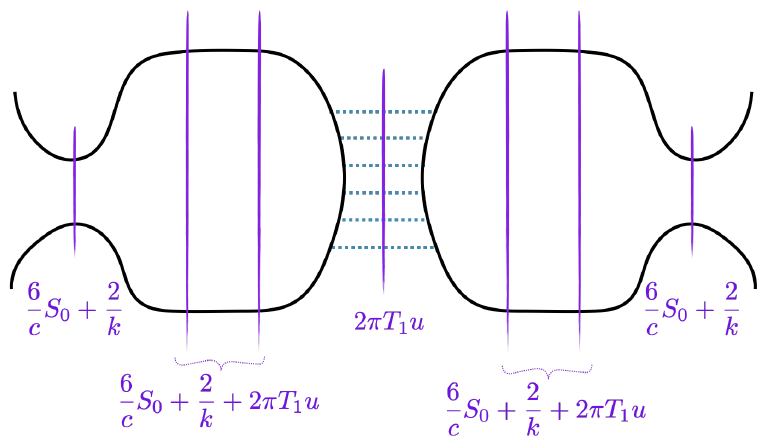
Figure 7. All the QESs in the disconnected history. Dashed blue lines denote entanglement DOFs, and purple lines mark the location of QESs, and they are labelled by the value of 6 S gen . u (cid:29) u Page . c The QESs marked with the same generalised entropies aren’t actually degenerate, but our analysis is insufficient to distinguish them. AdS boundaries are at the far left/right of the figure above. We have defined the quantity k = c 6 πφ r T 0